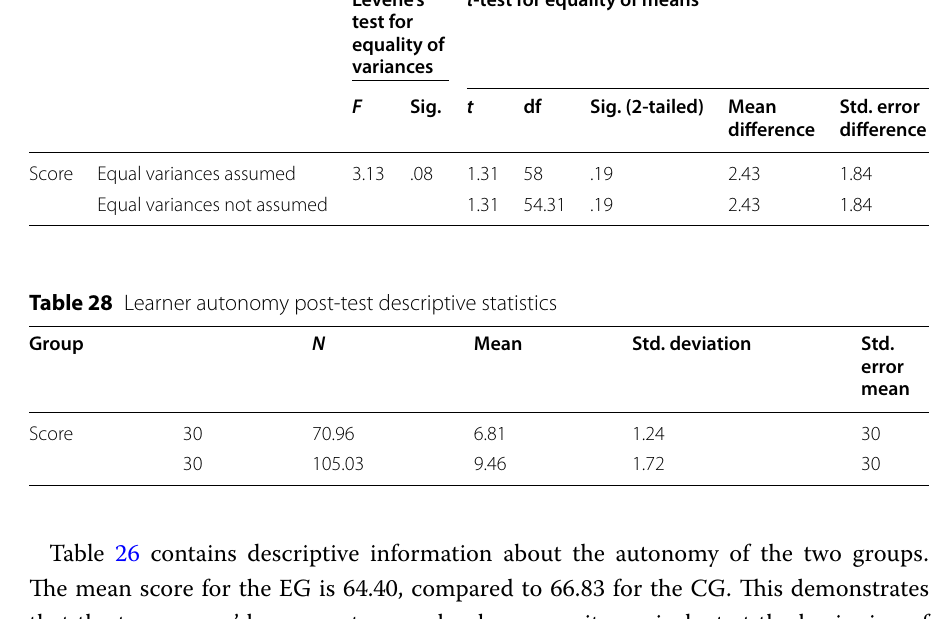
Table 26 contains descriptive information about the autonomy of the two groups.